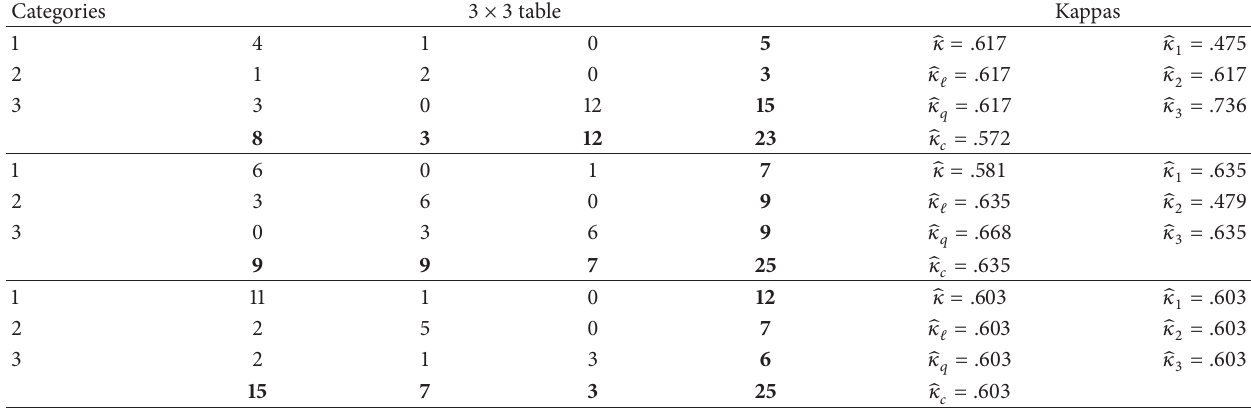
Table 4: Three hypothetical 3 × 3 agreement tables with corresponding values of weighted